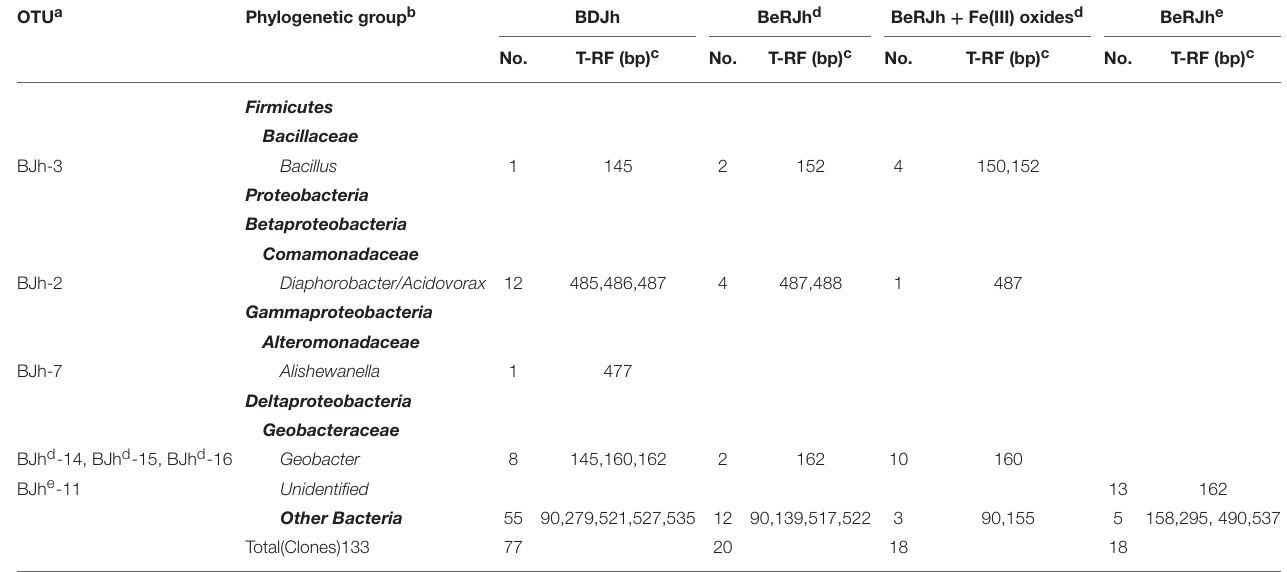
TABLE 2 | Phylogenetic affiliation of 16S rRNA sequences retrieved in clone libraries generated from three different sites with major bacterial lineages of clones falling into major MspI-specific T-RF classes. OTU a Phylogenetic group